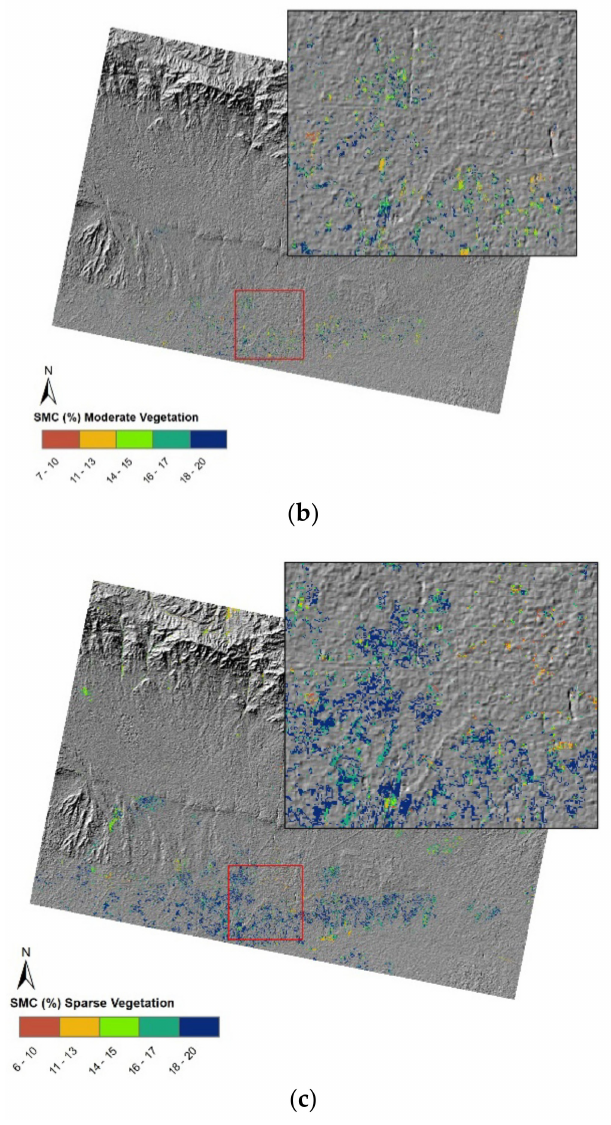
Figure 8. Soil moisture status in three NDVI classes: ( a ) dense, ( b ) moderate, and ( c ) sparse vegetation, over the croplands (Red box) in the study area on 7 March